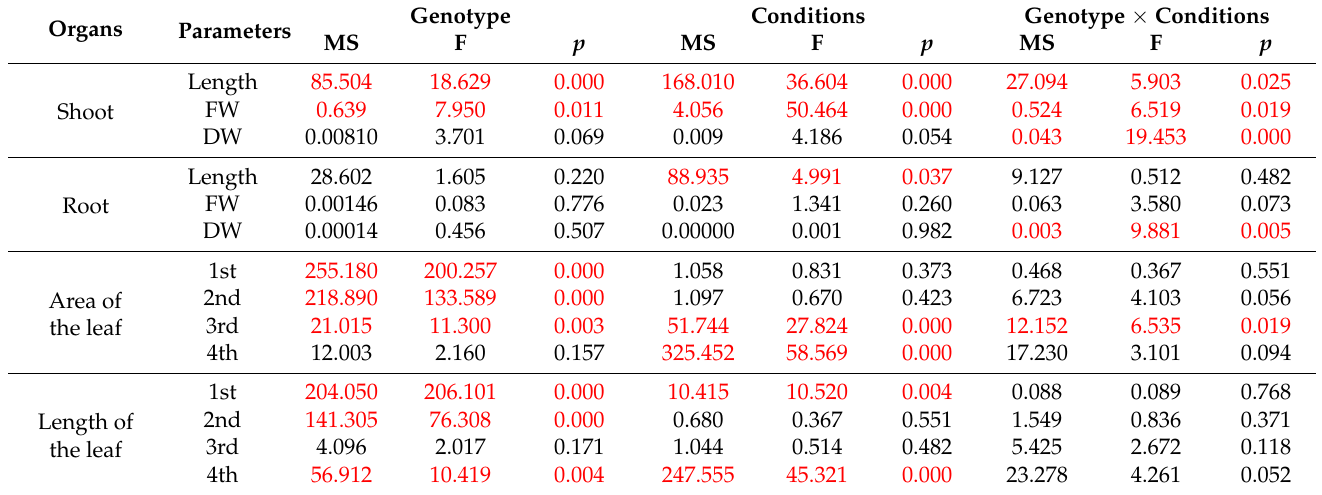
Table 1. Results of two-way ANOVA for two barley genotypes (Golden Promise and Haruna Nijo) grown under two conditions (control conditions and salt stress induced by 150 mM sodium chloride) were calculated for aboveground and belowground organ traits (length; FW, fresh weight; DW, dry weight; area). MS—mean square; F—F-test; p—p-value ; red characters—significant